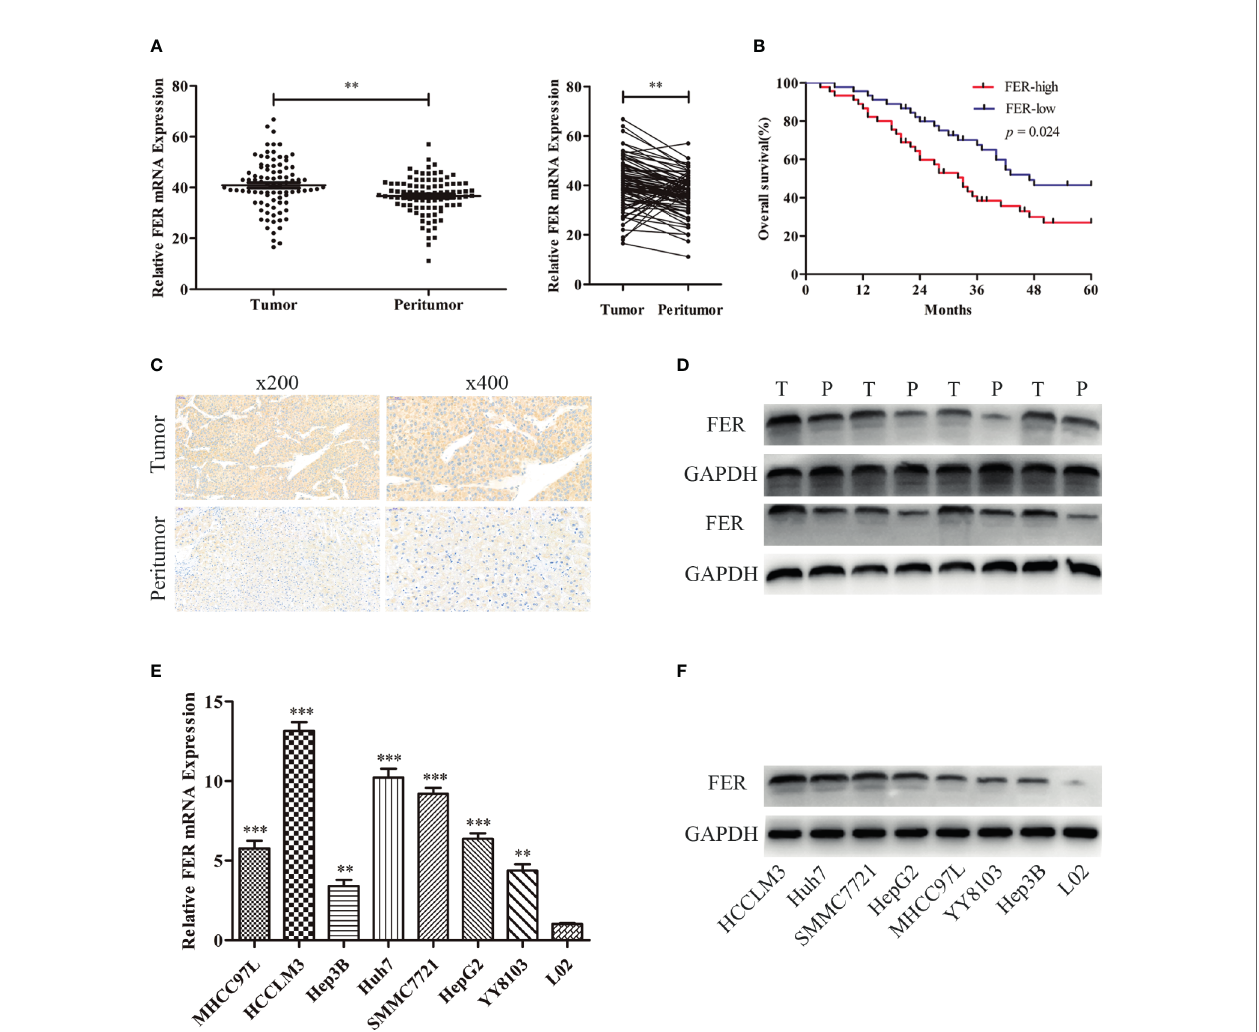
FIGURE 1 | FER is upregulated in HCC and is correlated with poor clinical prognosis. (A) FER mRNA expression was analyzed in 90 pairs of HCC samples and the related paracancerous tissue samples by RT-qPCR. (B) The overall survival (OS) of patients with variable FER expression was assessed via Kaplan-Meier analyses. (C) The results of FER IHC staining in HCC tumor tissues and corresponding peritumor tissues. (D) The results of western blotting of FER in HCC tissues and peritumor tissues. (E) FER mRNA expression levels in HCC cell lines and the immortalized human hepatocyte L02 cell line. (F) Western blotting analysis of FER protein levels in HCC cell lines and normal hepatic L02 cell line. The data are presented as the mean ± SD of three independent experiments. (T, tumor; P, peritumor; **P < 0.01, ***P <